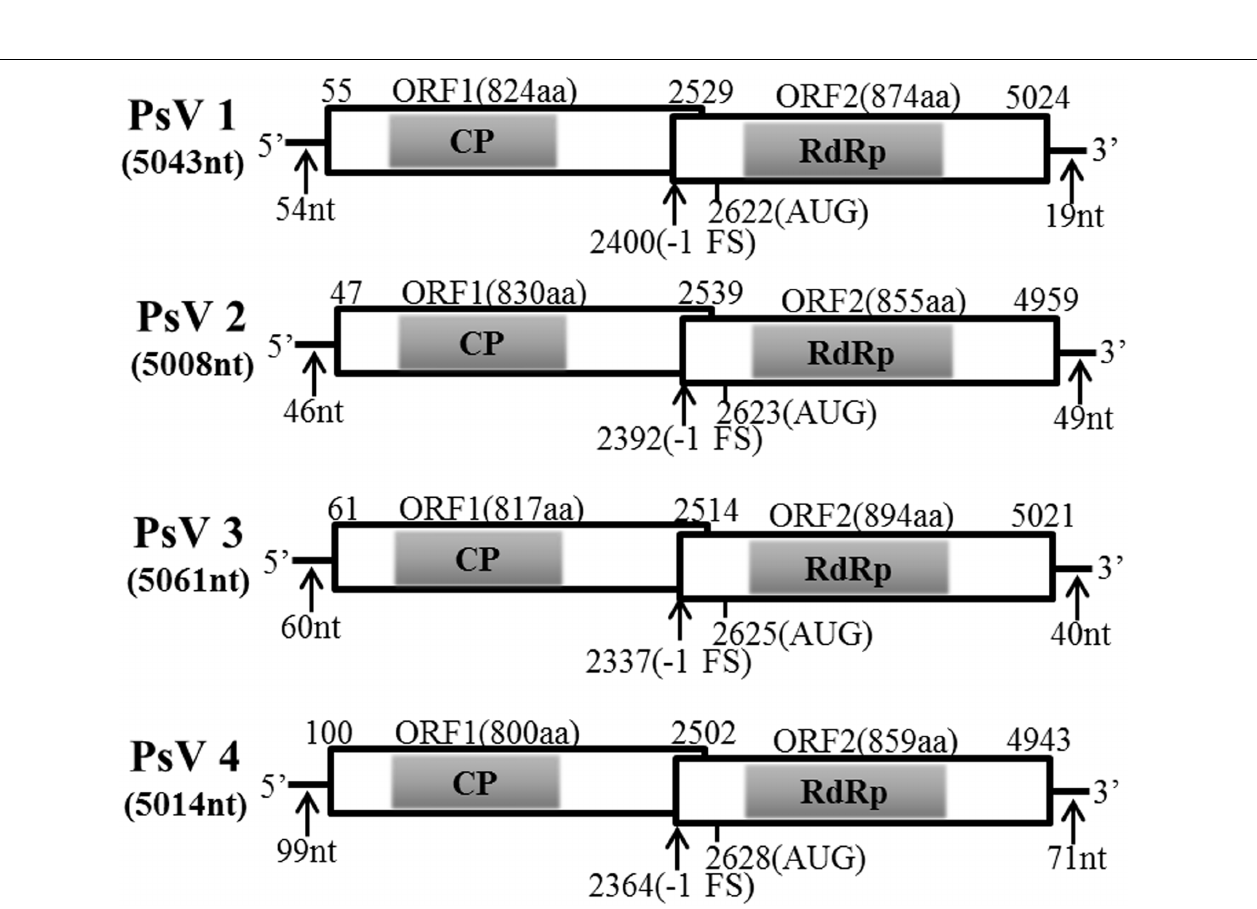
FIGURE 2 | Genomic organizations of PsVs sequences. The two overlapping ORFs and the untranslated regions (UTRs) are shown by open boxes and a single line, respectively. The conserved CPs and RdRps domain are indicated by shadows. Nucleotide positions of ORFs and the putative slippery site for − 1 frameshifting are shown with black